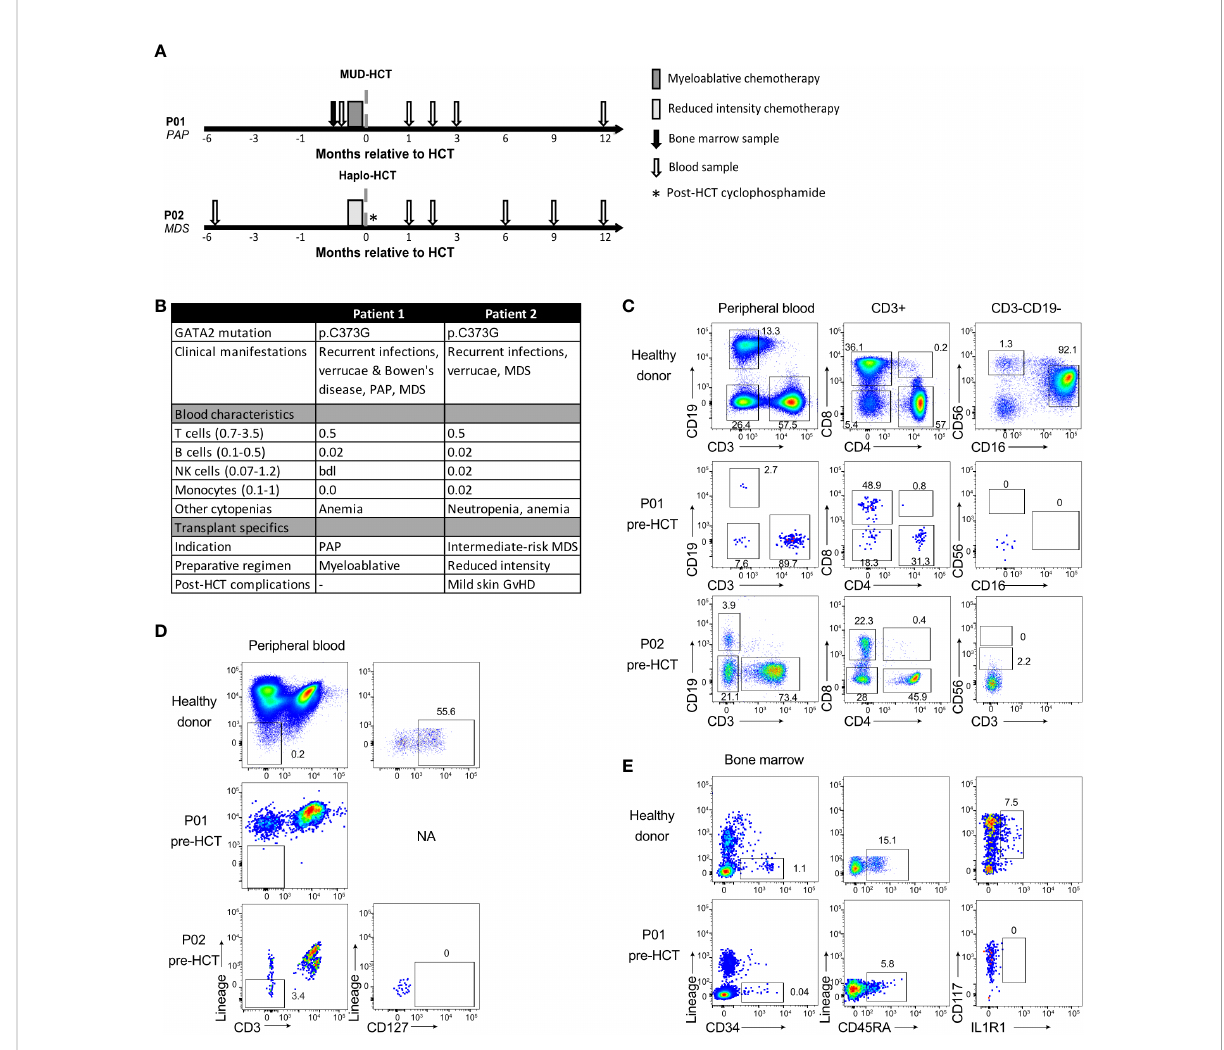
FIGURE 1 De fi ciency of T, B, NK cell and ILC in GATA2 haploinsuf fi ciency. (A) Schematic overview of patient treatment schedules and timing of sample collection. Conditioning regimens: P01: busulfan, fl udarabine, anti-thymocyte globulin; P02: cyclophosphamide, fl udarabine, total body irradiation (TBI, 2 Gy) and post-transplant cyclophosphamide. Haplo, haploidentical; HCT, hematopoietic cell transplantation; MDS, myelodysplastic syndrome; MUD, matched unrelated donor; PAP, pulmonary alveolar proteinosis. (B) Patient characteristics and absolute cell numbers (x109/L) of T cells, B cells, NK cells and monocytes (Mono) in peripheral blood at time of diagnosis of GATA2 haploinsuf fi ciency or shortly after. bdl, below detection level; GvHD, graft-versus-host disease; HCT, hematopoietic cell transplantation; NA, not applicable; MDS, myelodysplastic syndrome; PAP, pulmonary alveolar proteinosis. (C) Flow cytometric analysis of T cells, B cells and NK cells in peripheral blood cryopreserved mononuclear cells from a healthy donor, P01 and P02 collected prior to allogeneic HCT. Cells are pre-gated on viable CD45+ lymphocytes (Figure S1) and B cells are CD19+, T cells are CD3+ and categorized into CD4+, CD8+, CD4-CD8- and CD4+CD8+ T cells. NK cells are CD19-CD3- cells and are categorized into CD56brightCD16- NK cells and CD56dimCD16+ NK cells. For P02, no CD16 staining was available. Full gating strategy is displayed in Figure S1A – C. (D) Flow cytometric analysis and gating strategy used for identi fi cation of the CD127+ ILC population in peripheral blood cryopreserved mononuclear cells from healthy donors (representative of n=3) and patients. Cells are pre- gated on viable CD45+ (Figure S2A – C) and ILCs are identi fi ed as lineage (CD1a, CD3, CD4, CD5, CD14, CD16, CD19, CD34, CD94 CD123, BDCA2, TCR ab , TCR gd and FcER1 a )- CD3- CD127+ cells. NA = not applicable. Full gating strategy is displayed in Figure S2A – C). (E) Flow cytometric analysis and gating strategy used for identi fi cation of the multipotent hematopoietic progenitor cells (HPC) and ILC precursors in cryopreserved mononuclear cells from BM of a healthy donor and P01. HPC are selected as Lineage- (CD1a, CD3, CD4, CD5, CD14, CD16, CD19, CD94 CD123, BDCA2, TCR ab , TCR gd and FcER1 a ) CD34+CD45RA+ and within this population ILC precursors are selected as CD117 +IL1R1+. P02 had too few HPC to staining for HPC and ILC precursors. Full gating strategy is displayed in Figure